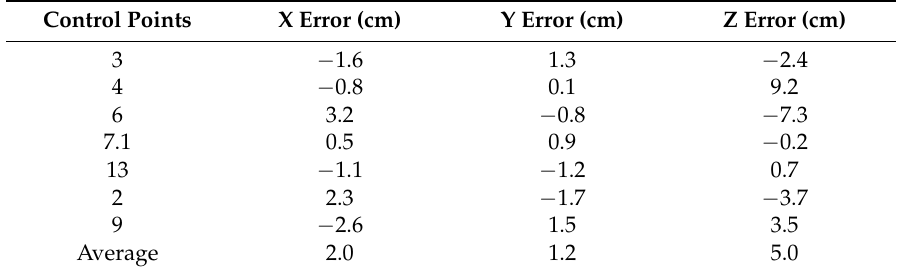
Table 1. Errors in X (easting), Y (northing), and Z (altitude) along control points.